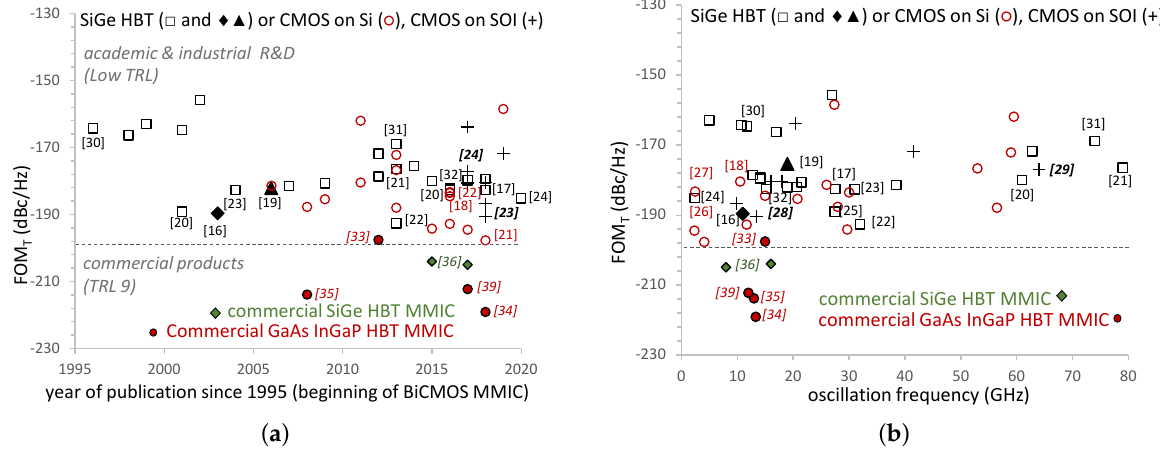
Figure 10. Evolution of the FoM T metric (Equation (5)) ( a ) with the year of publication ( b ) versus the oscillation frequency. Some references used in the paper are noted close to the associated symbol